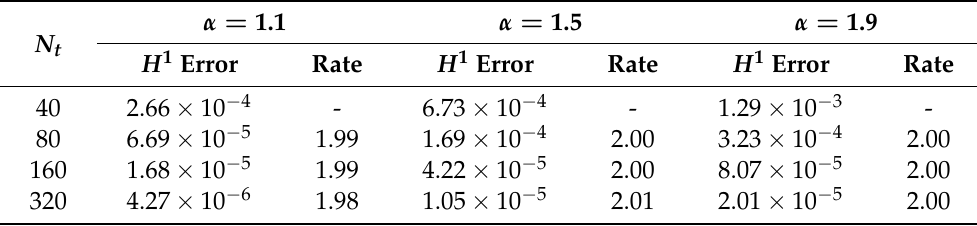
Table 1. The H 1 -norm errors in time for the smooth case in Example 1 with h = 1/64.